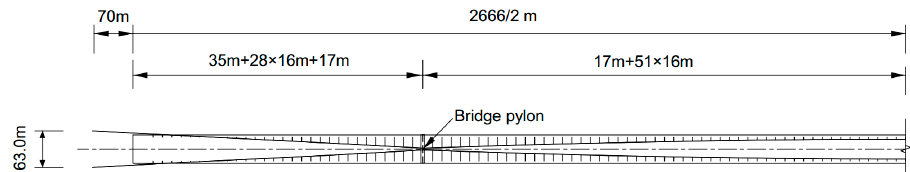
Figure 10. Top view of the suspension bridge using spatial main cables (A half of the bridge).